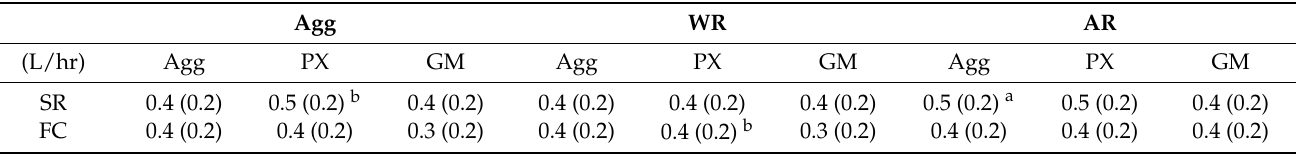
Table 3. Sweat rate and fluid consumed of all youth football players ( n = 63) from weight ( n = 27) and age ( n = 36) restricted leagues, during combined practices and